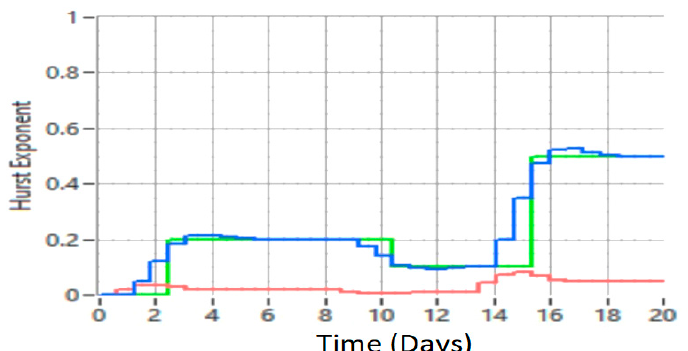
Figure 21. Detection of failures and intrusions in the data network traffic obtained with the proposed method (blue line) compared to the classic MPC method (red line). The green line represents the reference.